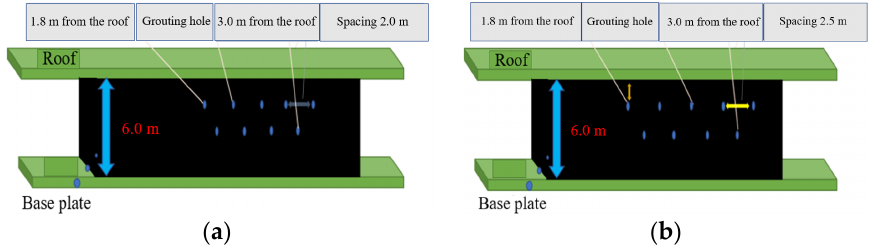
Figure 13. Reinforcement model of double-row grouting pipe: ( a ) spacing of 2.0 m; ( b ) spacing of 2.5 m.